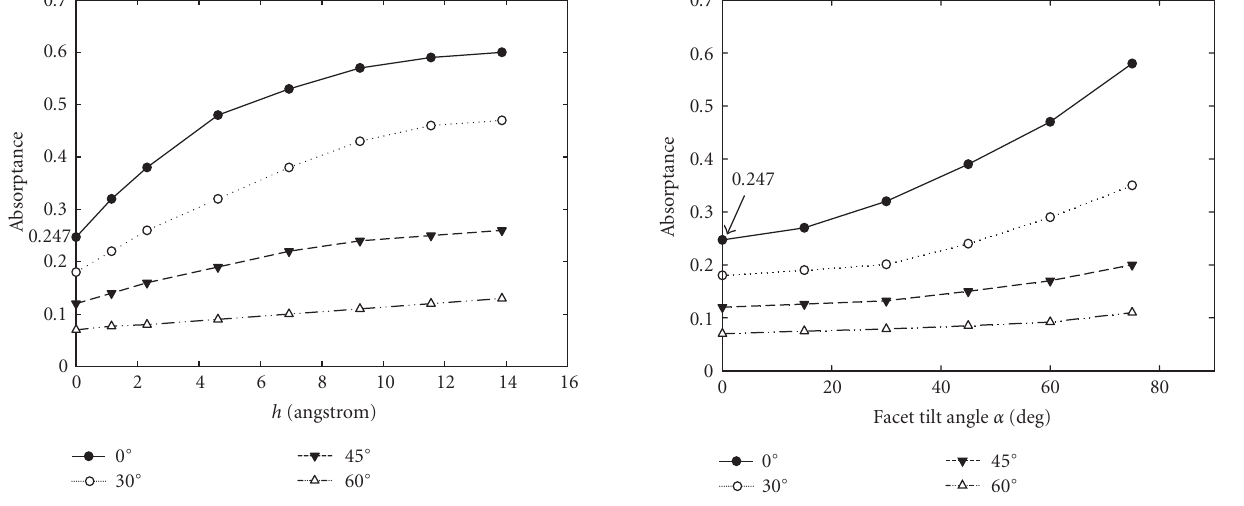
Figure 5: The relation among absorptance, facet titled angle α , and photon’s incidence angle θ .